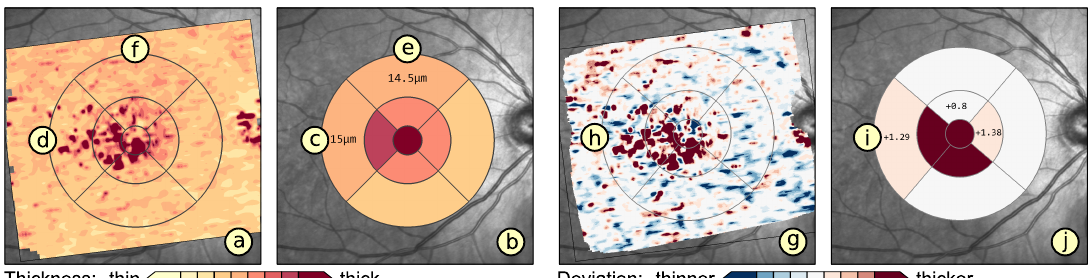
Figure 3. Problems with an ETDRS grid-based data representation. The thickness of a retinal layer is shown via a thickness map ( a ) and an ETDRS grid ( b ). A cell ( c ) with localized regions of high thickness, visible in the map (dark red; d ), has almost the same aggregated value in the grid as a cell ( e ) without such regions in the map ( f ). In the second map ( g ), localized regions of positive and negative deviations in thickness (dark red and dark blue; h ) are nearly nullified due to data aggregation in corresponding cells ( i ) of the grid ( j